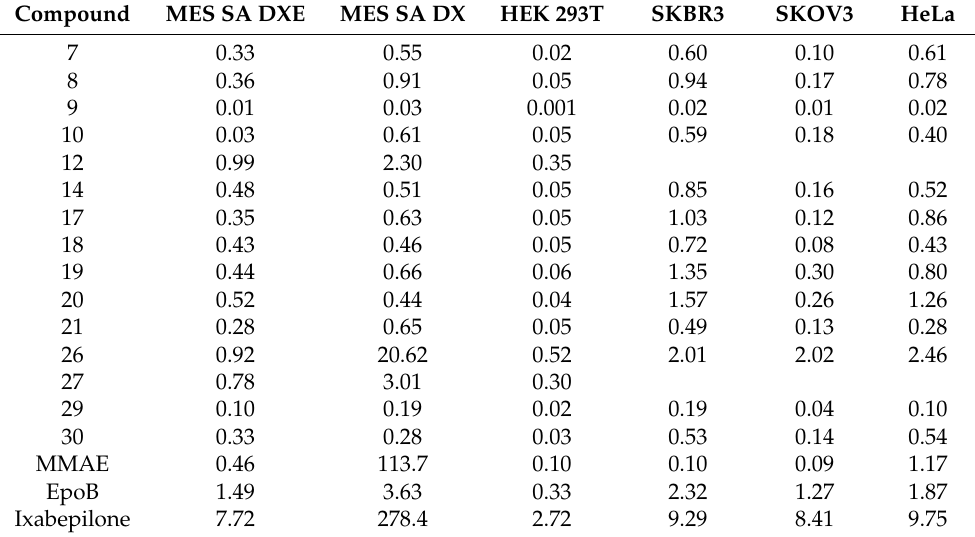
Table 4. Cytotoxicity values for selected synthetic epothilone compounds, IC 50 in nM.